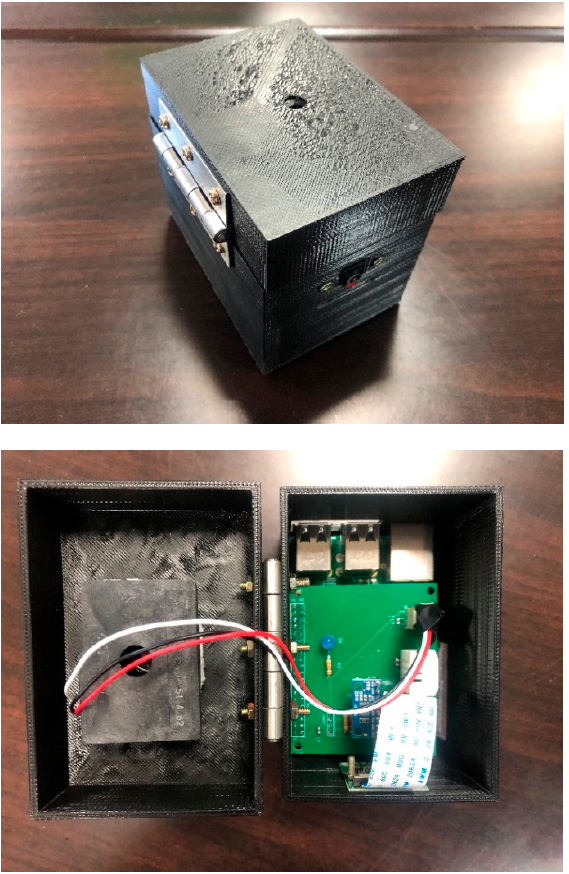
Figure 11. Setting of our implementation.